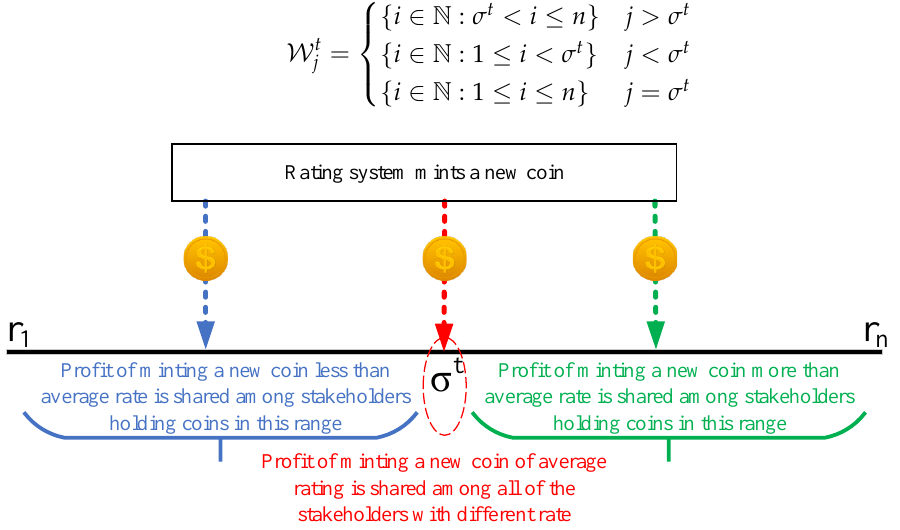
Figure 4. Sharing profit among stakeholders.